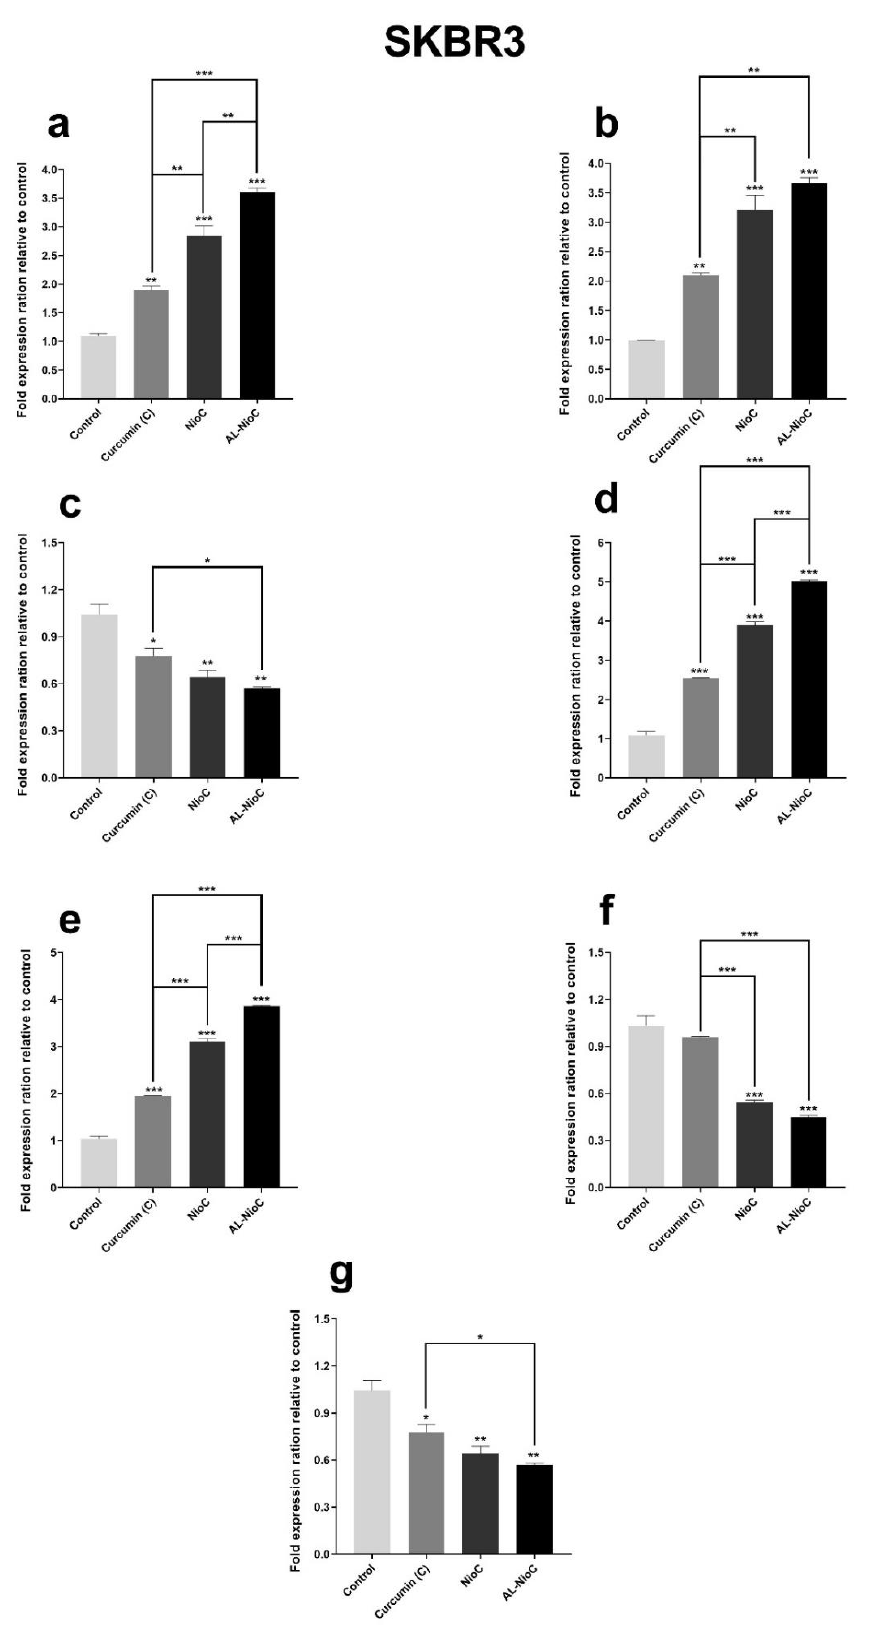
Figure 9. The expression of ( a ) Bax, ( b ) P53, ( c ) Bcl2, ( d ) Caspase 3, ( e ) Caspase 9, ( f ) CyclinD, and ( g ) Cyclin E genes in MDA-MB-231 and SKBR3 cells after treatment with different samples. The IC50 was used for each sample. The p -values are * p < 0.05, ** p < 0.01, *** p <